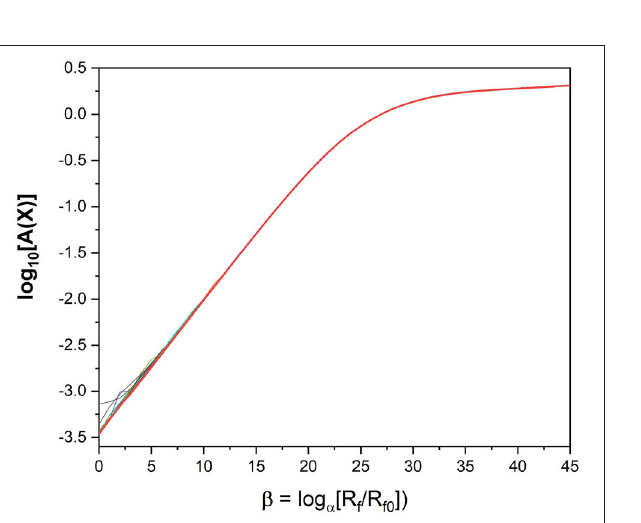
TABLE 2 | Parameter Estimates from the Best Predictions. Parameter Bounds